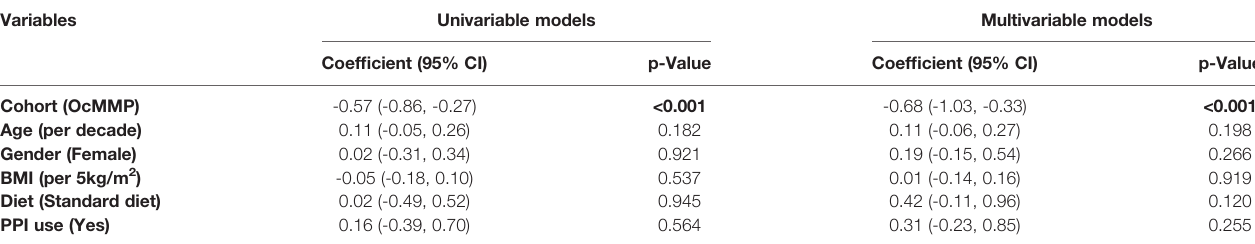
TABLE 4 | Linear regression models of Shannon Diversity Index in OcMMP vs. healthy